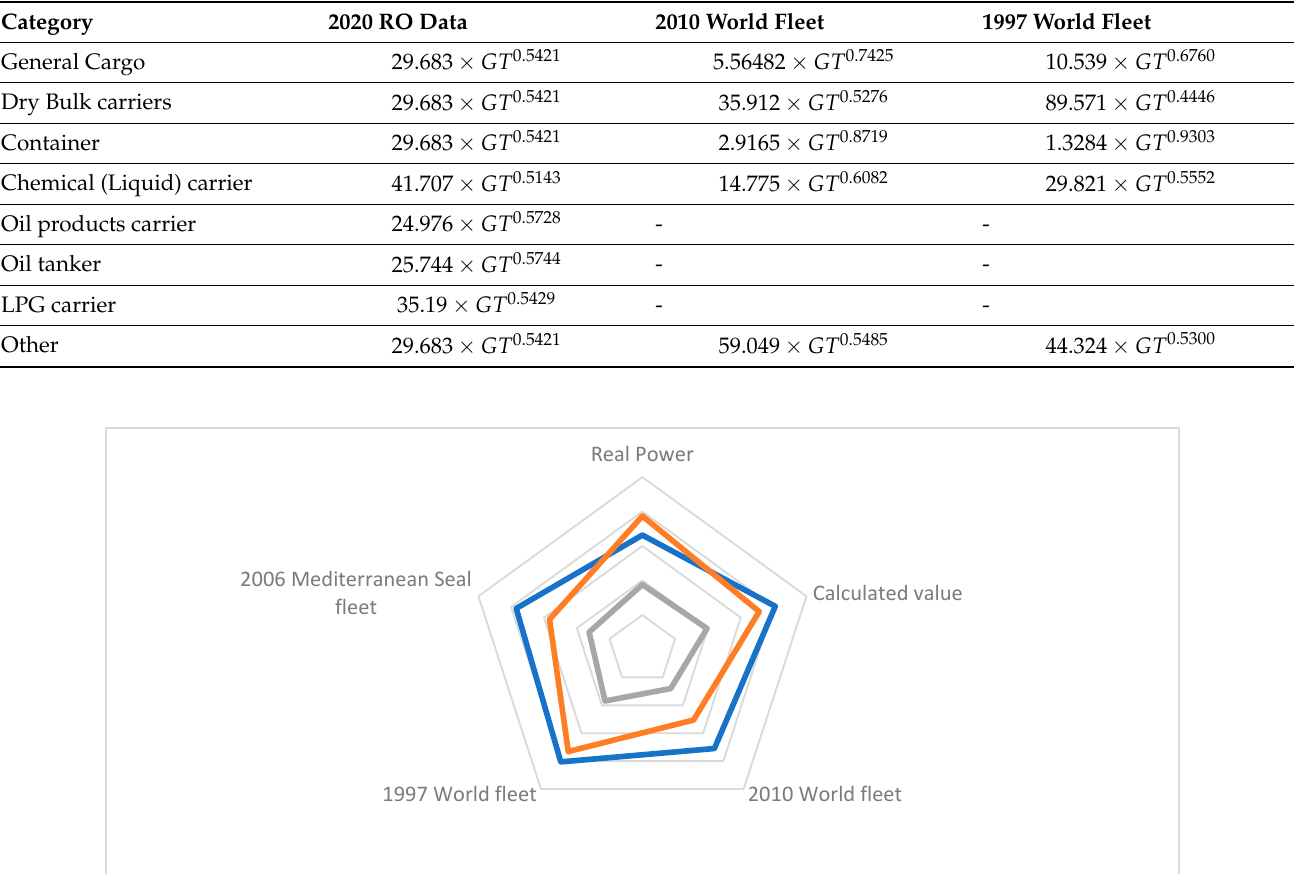
Table 8. Quantitative relationship between ME and GT.